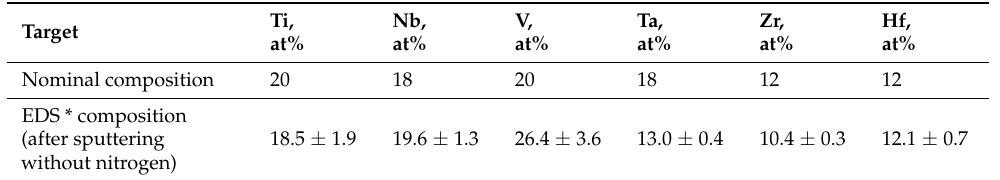
Table 1. The nominal and true average compositions of the target obtained by averaging 7 EDS/SEM (top view) measurements from the surface area of 900 × 680 µ m 2